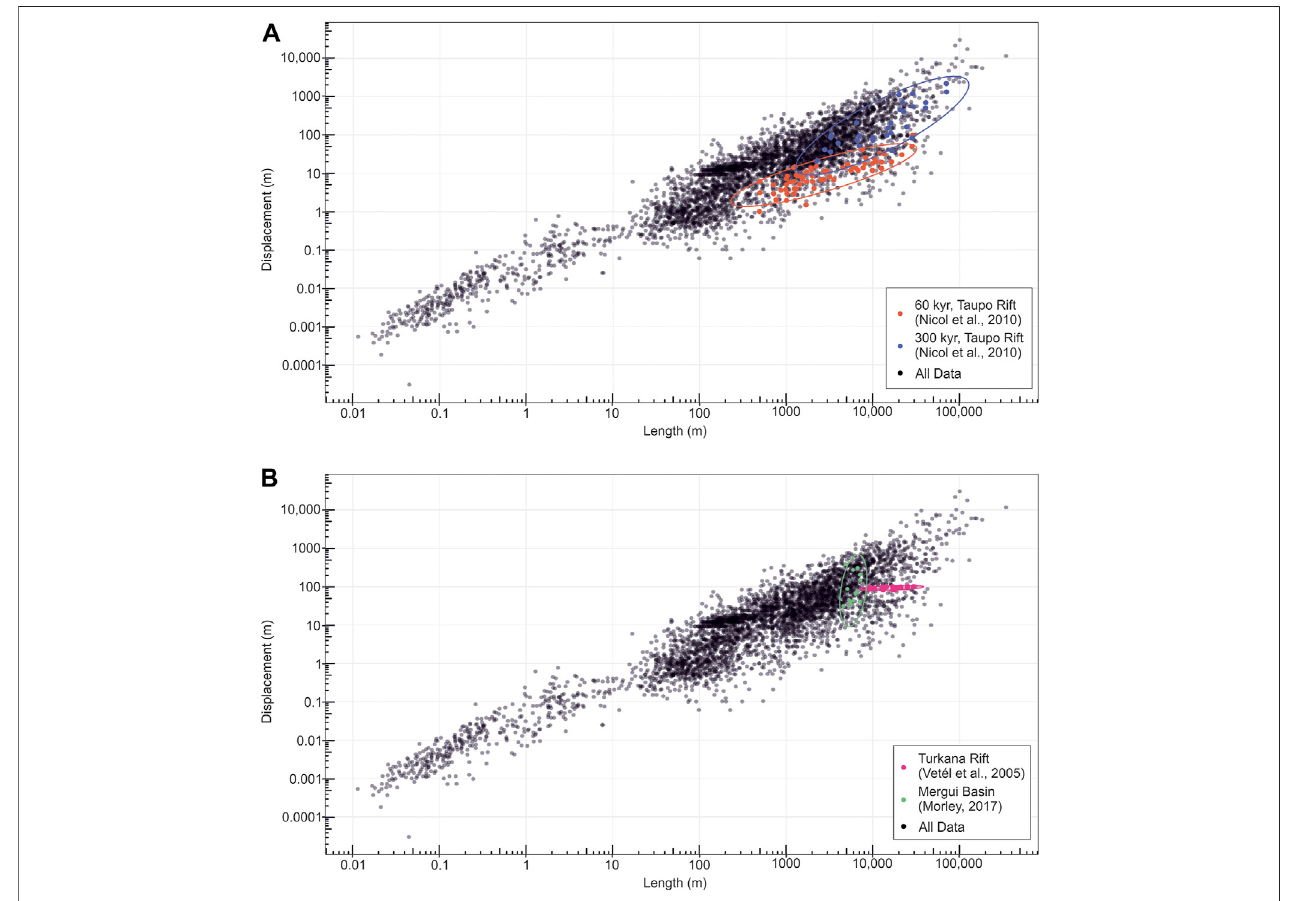
FIGURE11|(A) GlobalD/Ldataset(black)fornormalfaultsinlog-logspacewithfaultsofdifferentmaturitieshighlighted:60 kyrfaultsfromtheTaupoRiftinorange and300kyrfaultsfromtheTaupoRiftinpurple(fromNicoletal.,2010). (B) GlobalD/Ldataset(black)fornormalfaultsinlog-logspacewithreactivatedfaultshighlighted: faults from the Turkana Rift in pink (from Vétel et al., 2005) and the Mergui Basin in green (from Morley, 2017).